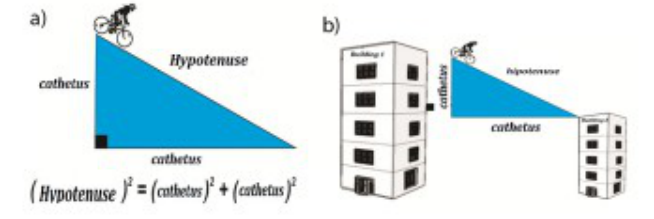
Figure 5. Remediaton for queston 4: a) used afer 1st unsuccessful atempt and b) used afer 2nd unsuccessful